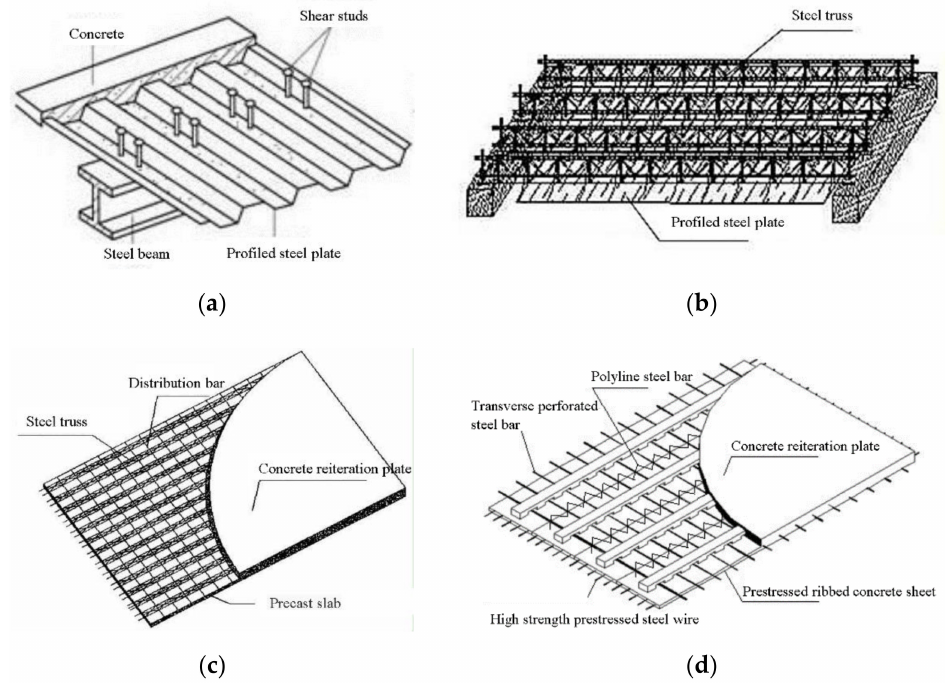
Figure 1. Pictures of existing precast slabs: ( a ) steel deck-concrete composite floor; ( b ) steel bar truss deck; ( c ) composite floor with steel tubular truss; and ( d ) precast ribbed slab-composite floor